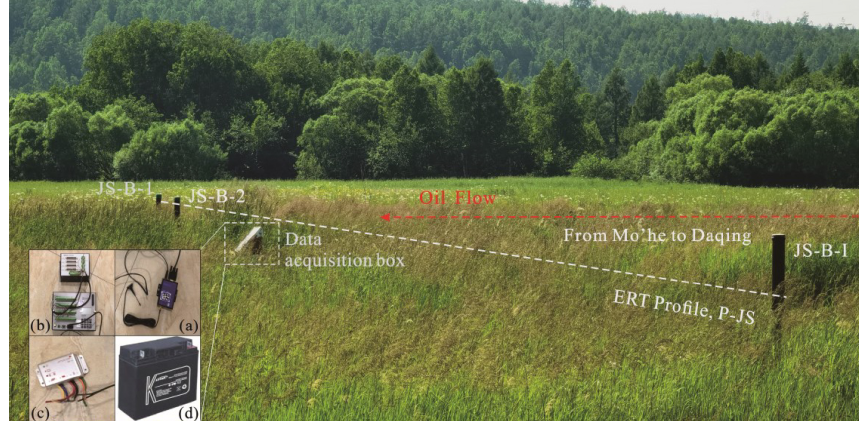
Figure C1. Position of boreholes drilled on and off the pipeline ROW and the ERT profile at the JS permafrost site. Photo was taken on 29 June 2021. Ground temperatures are measured using thermistor chains connected to the CR3000 data logger. Notes: (a) wireless transmission module (HKT-DTU, Campbell Scientific, Inc., USA), (b) CR3000 data logger with a TRM128 multiplexer, (c) solar charge